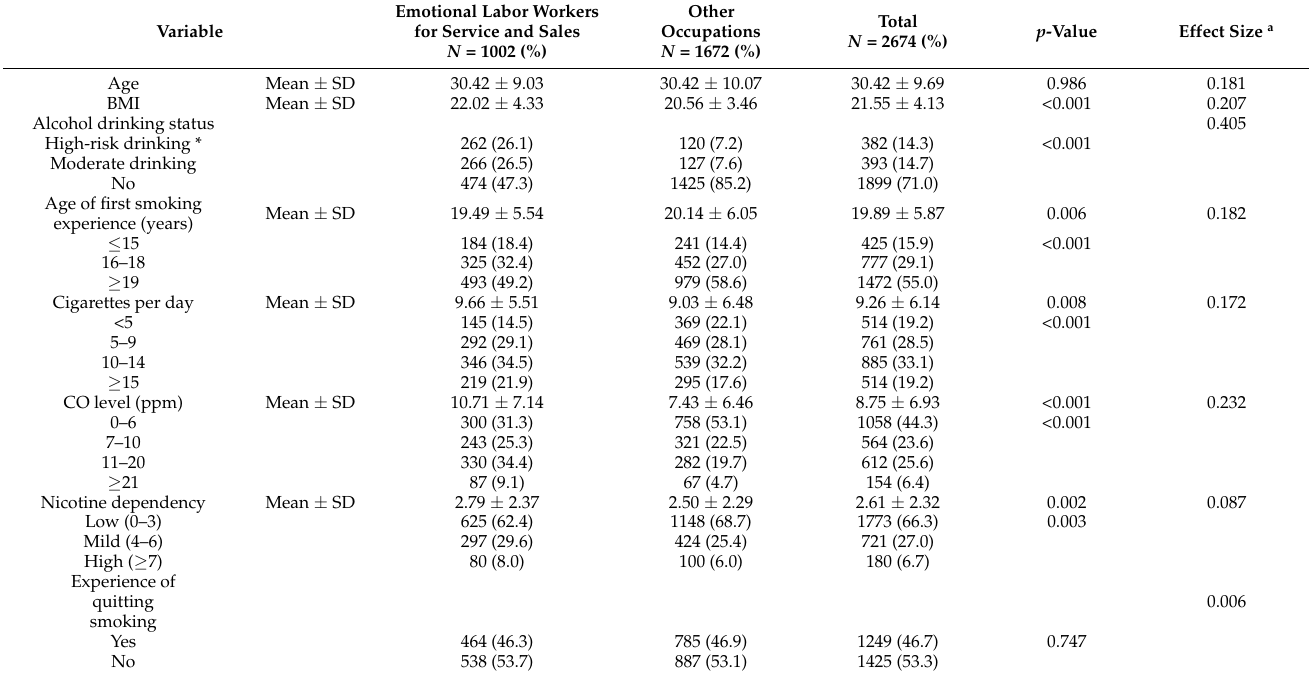
Table 1. Health and smoking-related characteristics according to labor status. Emotional Labor Workers Variable for Service and Sales